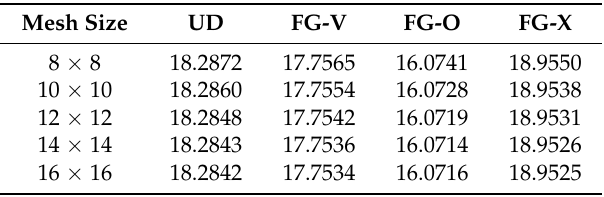
Table 1. Convergence study of the present results for the dimensionless frequency parameter of a CNT-reinforced plate for clamped boundary